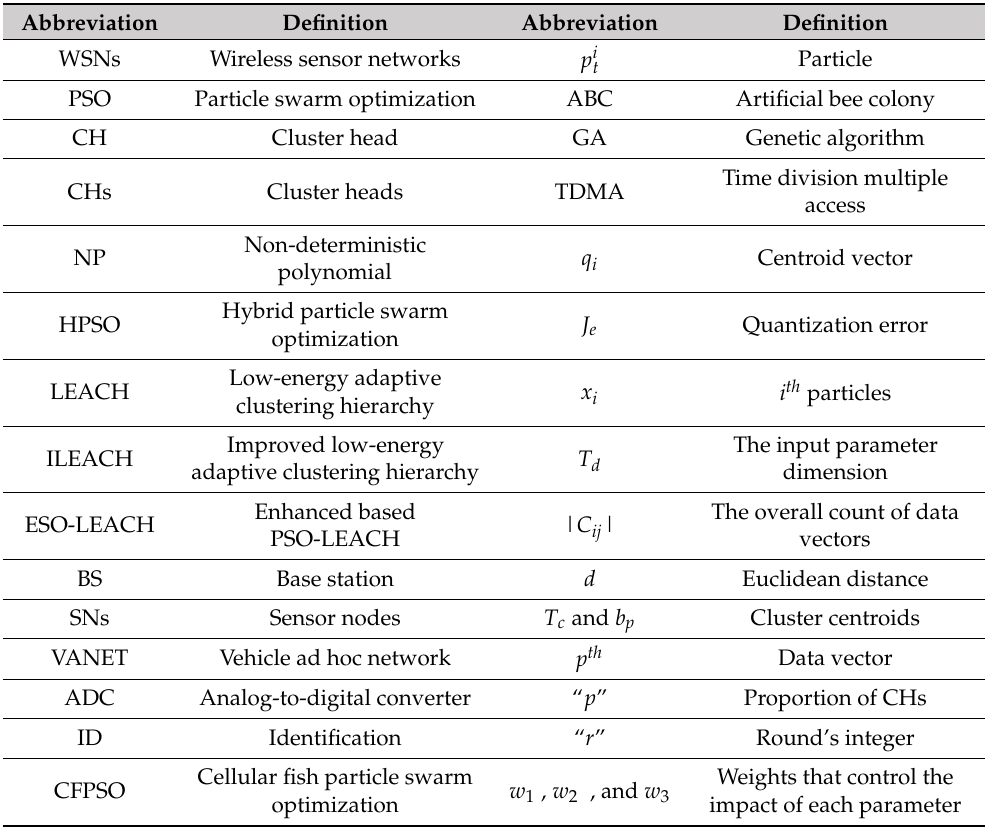
Table 1. List of symbols and